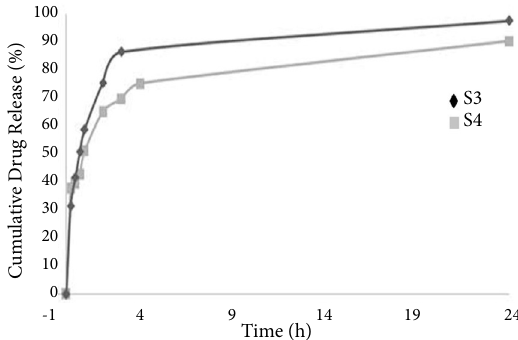
Fig. 6. Release of BSA from nanocapsule of PLGA/BSA with different ratio, (S3) 0.4/0.1 w/v, (S4) 0.45/0.05